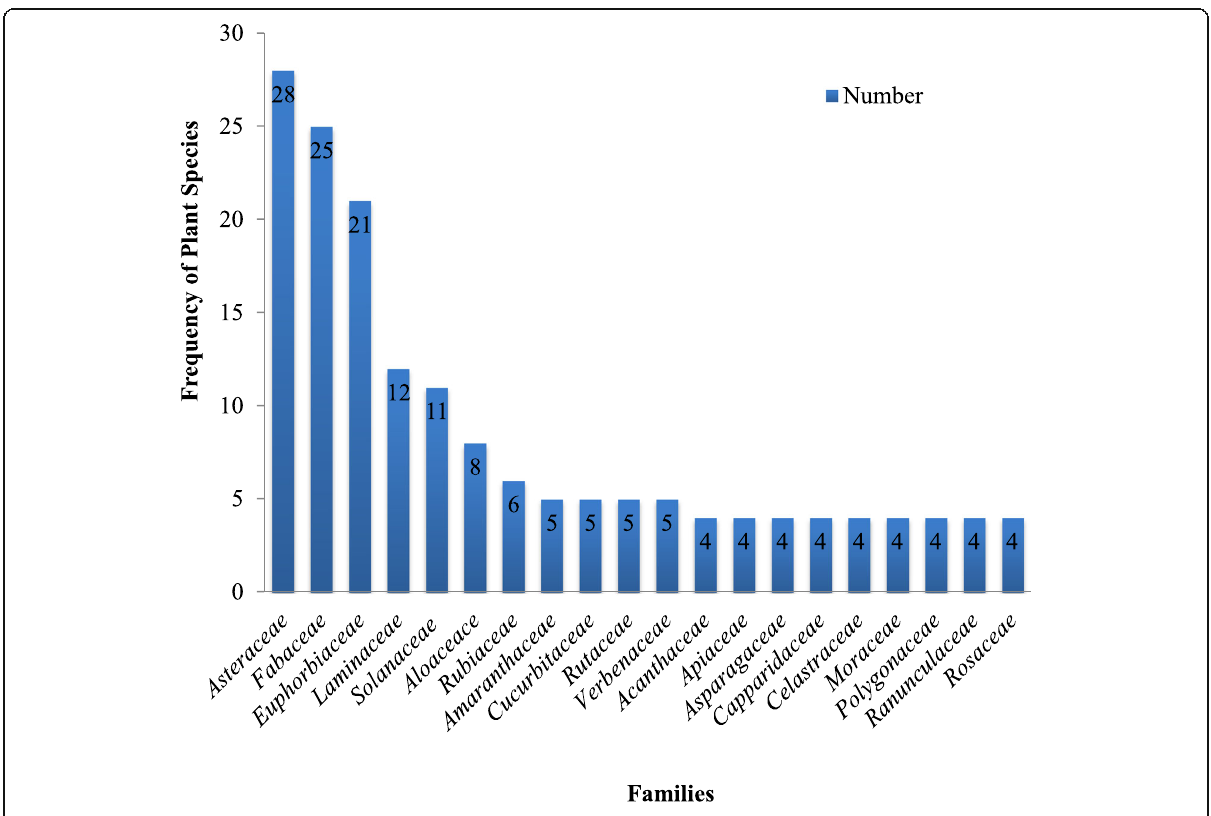
Fig. 1 Frequently used plant families for the treatment of hepatic disorders in